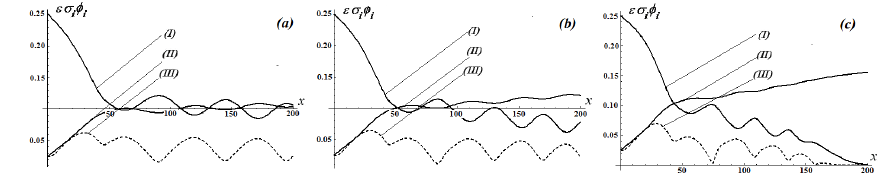
Figure 3. Modulation of surface waves by the adverse current U = U 0 x . (a) U 0 = − 2 . 510 − 4 , (b) U 0 = − 510 − 4 , (c) U 0 = − 10 − 3 . (I), (II), (III) – amplitude envelopes of the carrier, subharmonic and superharmonic waves, respectively. Initial wave steepness ε = 0 . 25, side bands amplitudes equal to 0.05 times the amplitude of the carrier.